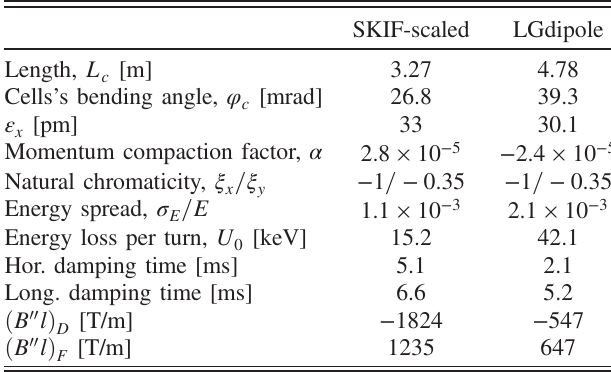
TABLE VIII. Comparison of parameters of the two cells for 6 GeV light source with emittance ε x ≈ 30 pm. The column titled “ SKIF-scaled ” is shown on the left of Fig. 26, “ LGdipole ”— on the